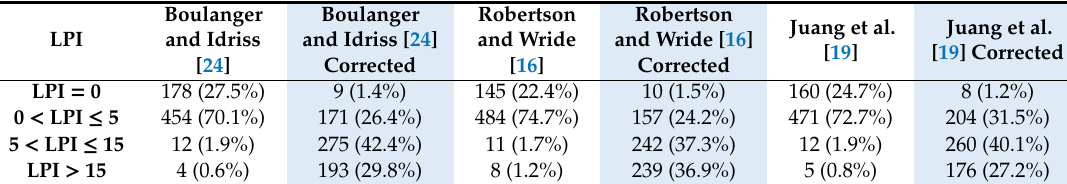
Table 9. Liquefaction severity classes for the macro-area of the Pisa plain (CPTs with depth ≥ 15 m).